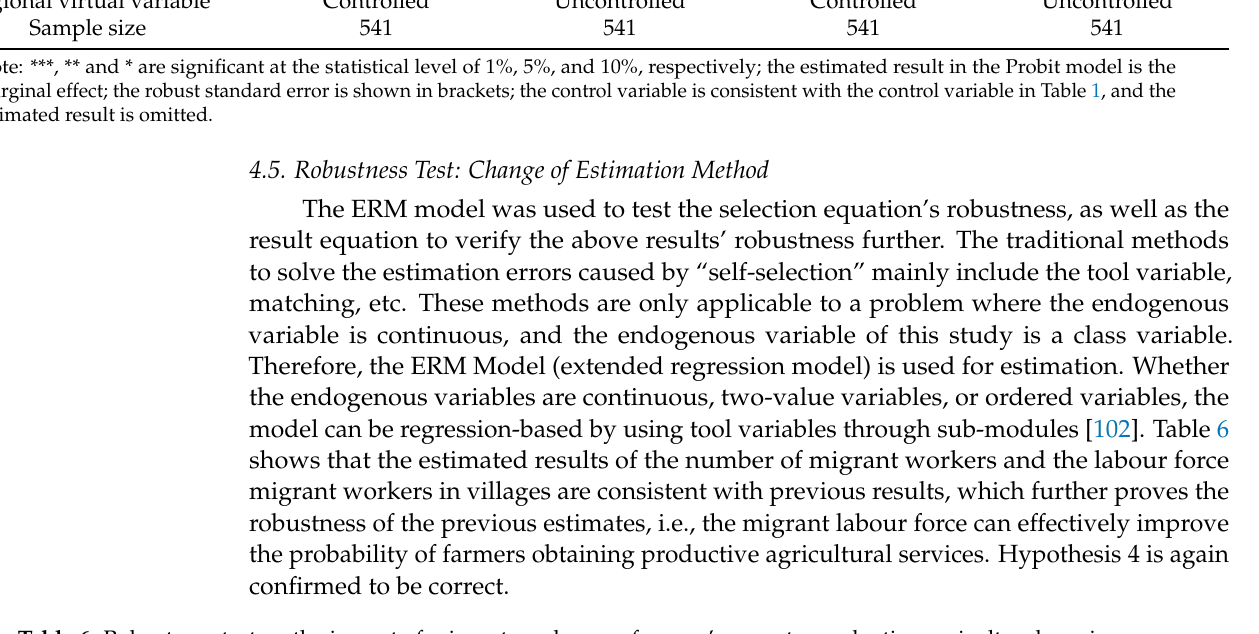
Table 6. Robustness test on the impact of migrant workers on farmers’ access to productive agricultural